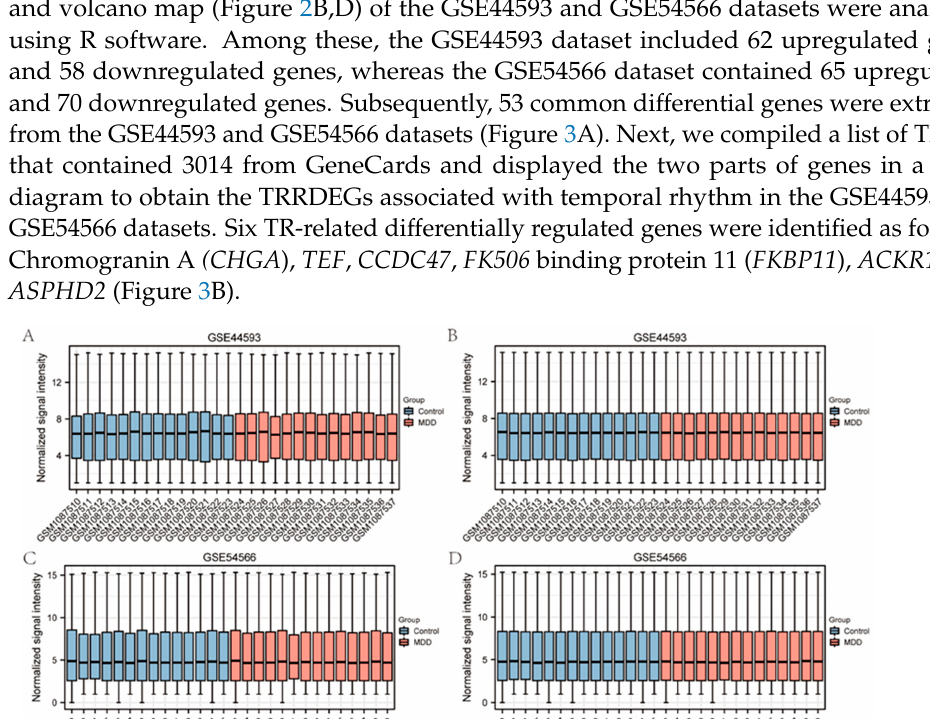
Figure 2. Results of DEGs. ( A ) Heatmap of GSE44593. ( B ) Heatmap of GSE74089. ( C ) Volcano plot of GSE44593. Red represents up-regulation of differential genes, green represents down-regulation of DEGs, and gray represents indifference. ( D ) Volcano plot of GSE54566.